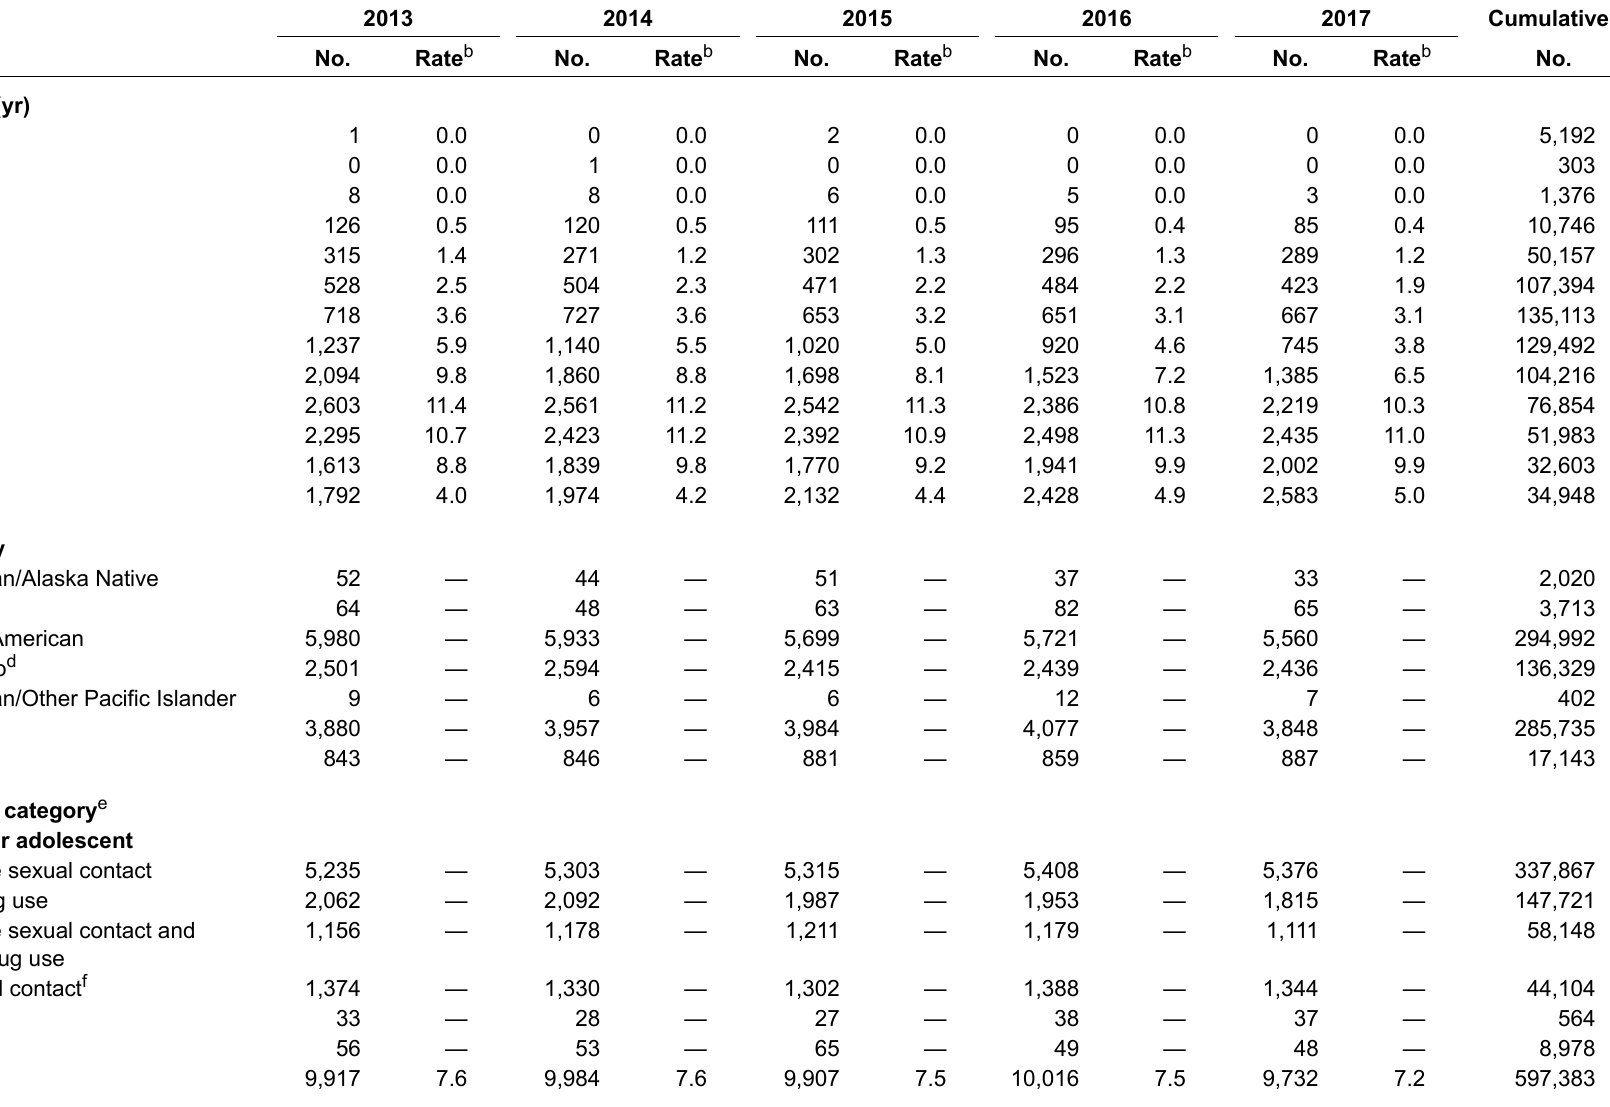
Table 19b. Deaths of persons with diagnosed HIV infection ever classified as stage 3 (AIDS), by year of death and selected characteristics, 2013–2017 and cumulative—United States and 6 dependent